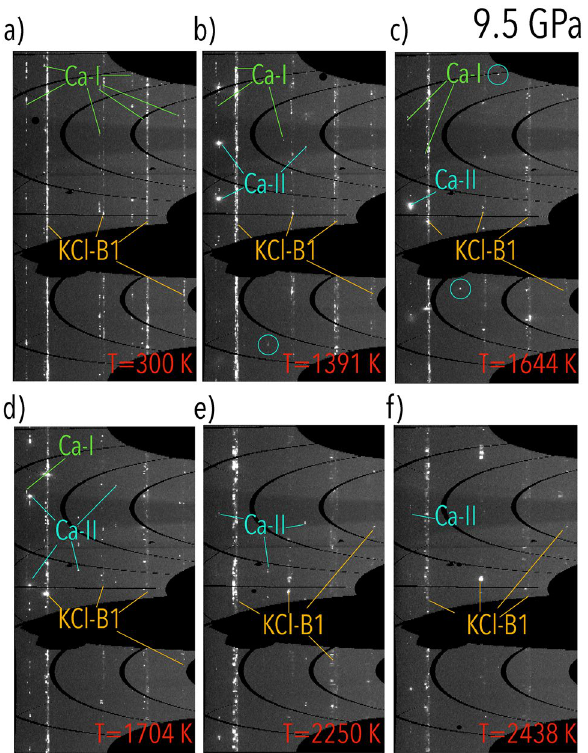
Figure 1. Textural evolution of a Ca sample embedded in KCl pressure transmitting medium at around 9.5 GPa. The different phases/samples observed in the patterns are highlighted with different colours: green for Ca-I, light blue for Ca-II and orange for